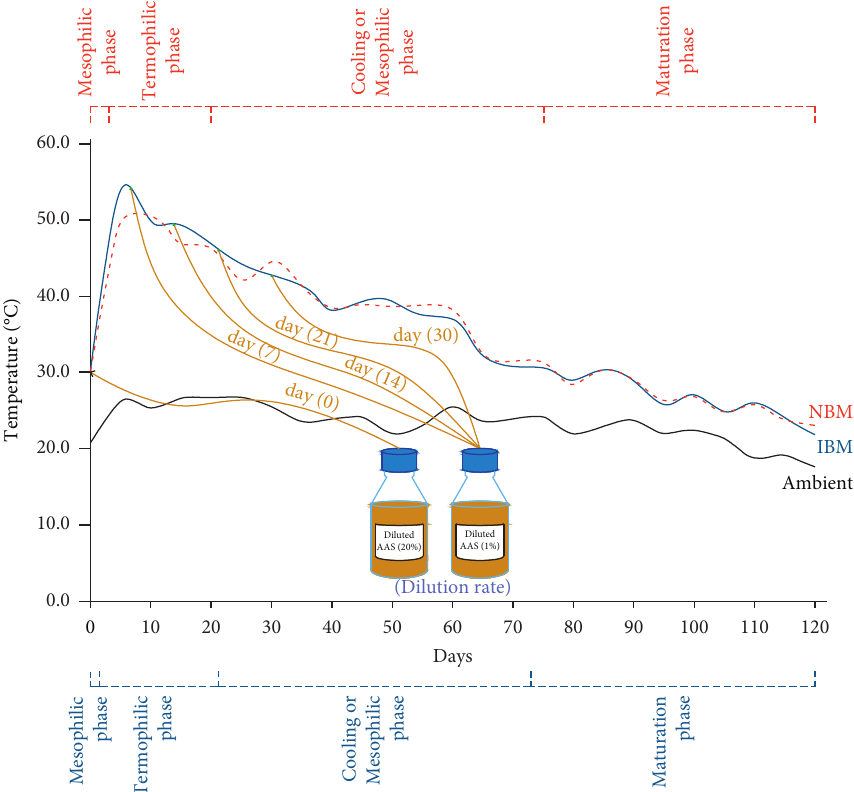
Figure 2: Days of inoculation of the compost piles with diluted activated stock solution (ASS), phases of the composting process and temperatures of the inoculated (IBM), and noninoculated (NBM) piles and the ambient temperature. Table 4: Microbiological analysis of beneficial micro-organisms—BM in the activated stock solution—ASS ( n � 3). T0 T30 Parameters Mean ± st. dev. Mean ± st. dev.